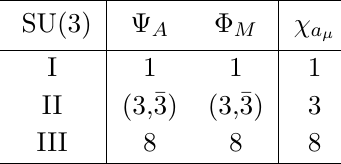
Table 4 . Table of the di(cid:11)erent SU(3) representations that can give a non-zero e(cid:11)ect to a (cid:22) . (cid:31) a denotes the resulting group